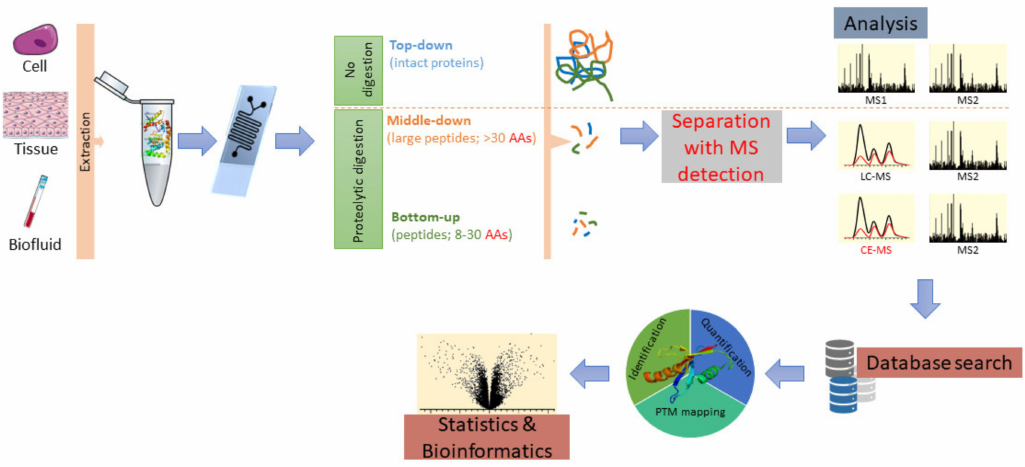
Figure 4. Schematic representation of proteomics